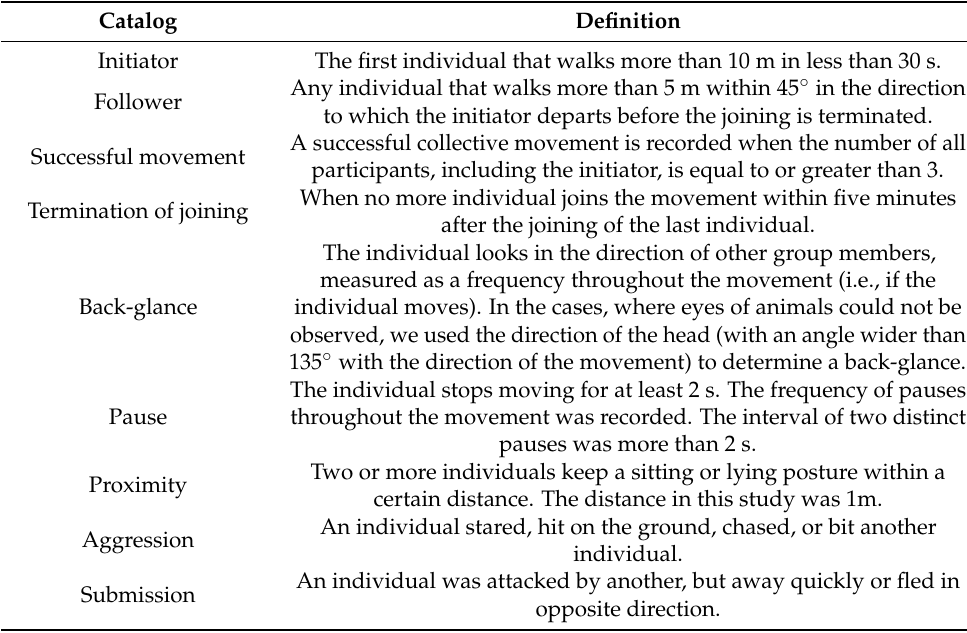
Table 1. Ethogram of behaviors recorded during focal animal